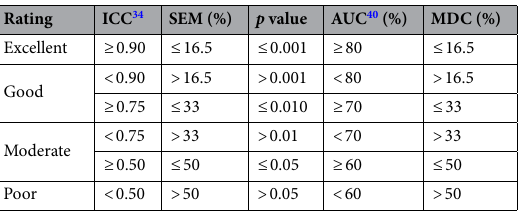
Table 2. Rating used for each measurement property evaluated. ICC intra-class correlation, SEM standard error of measurement, AUC area under curve, MDC minimal detectable